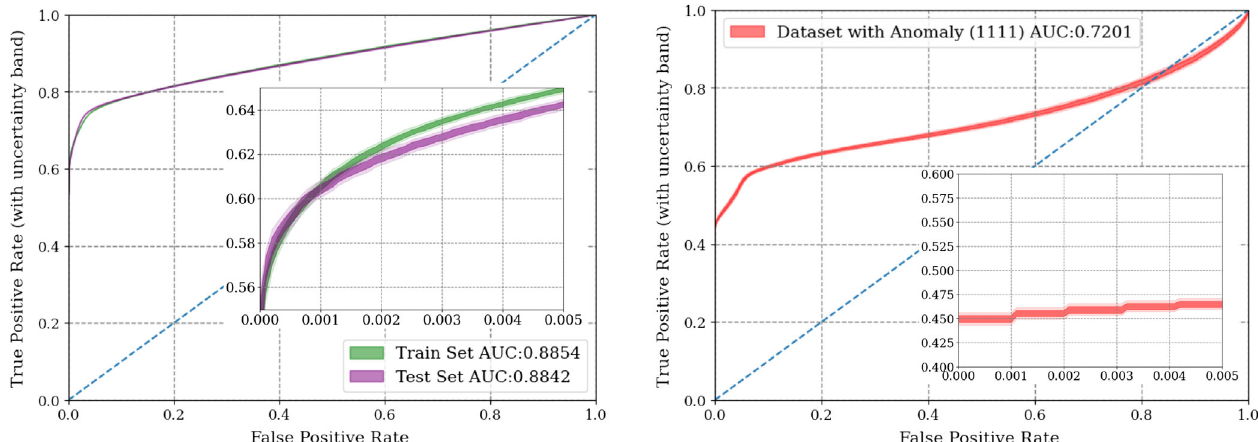
FIG. 6. The ROC curves for training and testing with the same (left) and different (right) errant types (from [63], Figs. 14 and